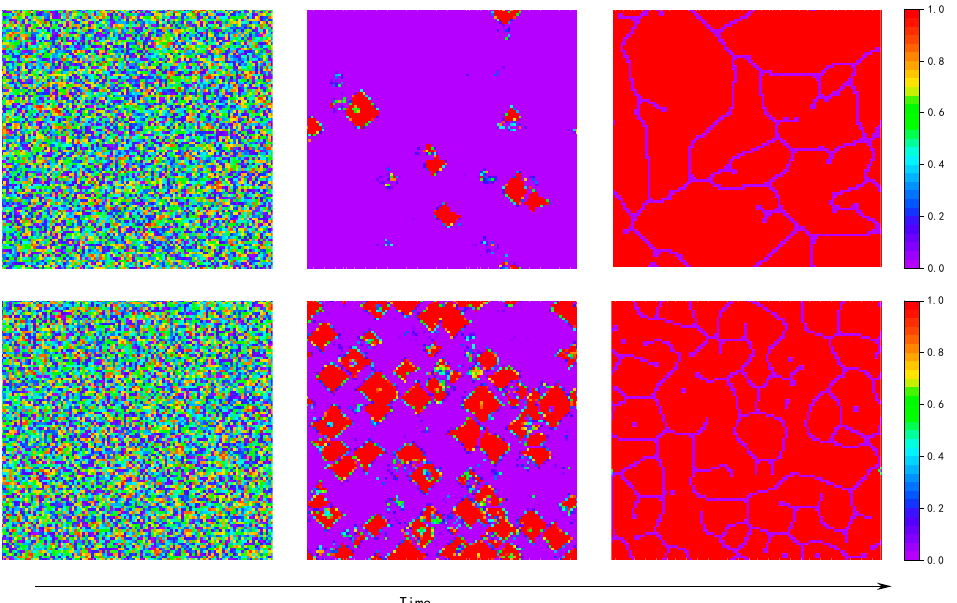
Figure 4. Variation of the average cooperation level with the 𝑟 for six different values of 𝛼 , where 𝜔 is fixed to 0.2 ( left ) and to 0.8 ( right ), respectively. In addition, the “original” curve represents the case of the Fermi update rule.